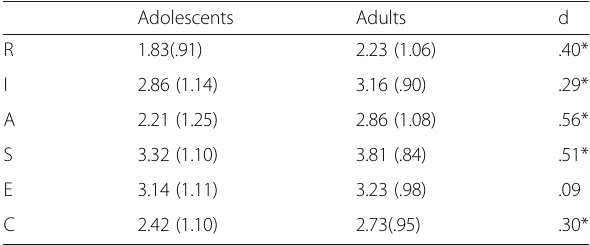
Table 4 Between-sample mean comparisons (standard deviations within